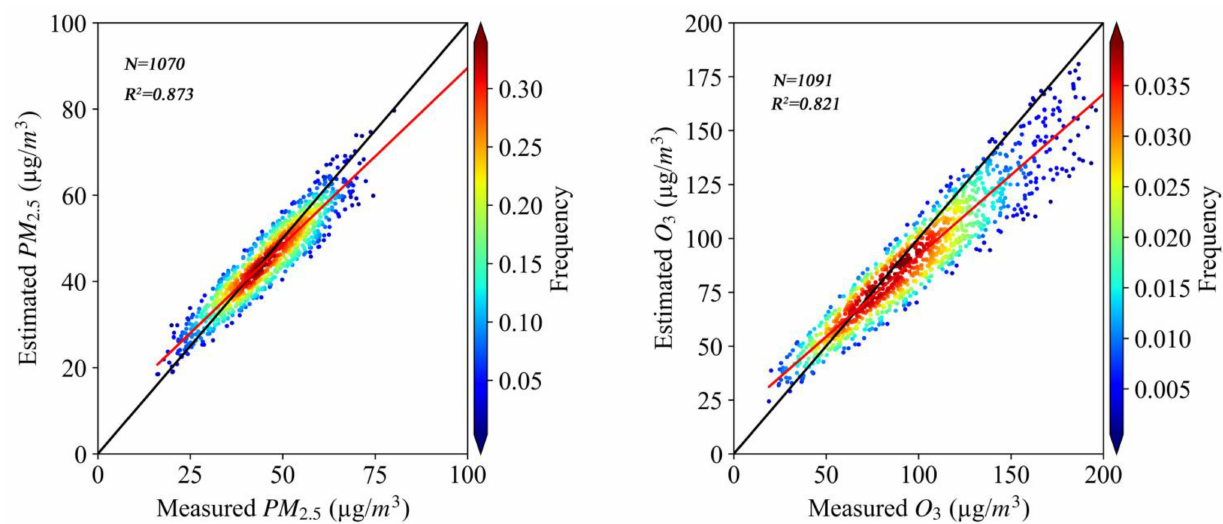
Figure A1. Validation of remote sensing estimates using ground-truth data.